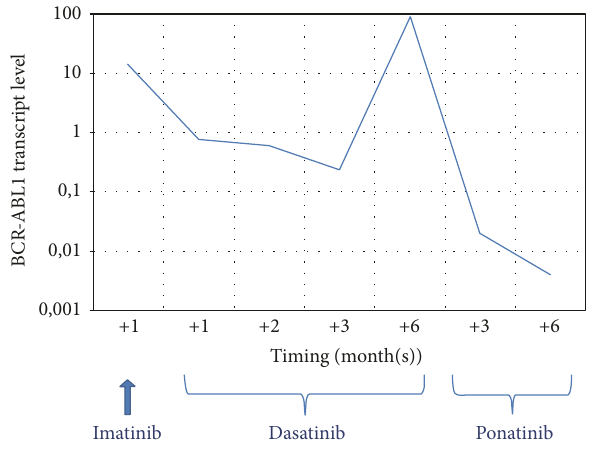
Figure 2: BCR-ABL1 transcript level during TKIs